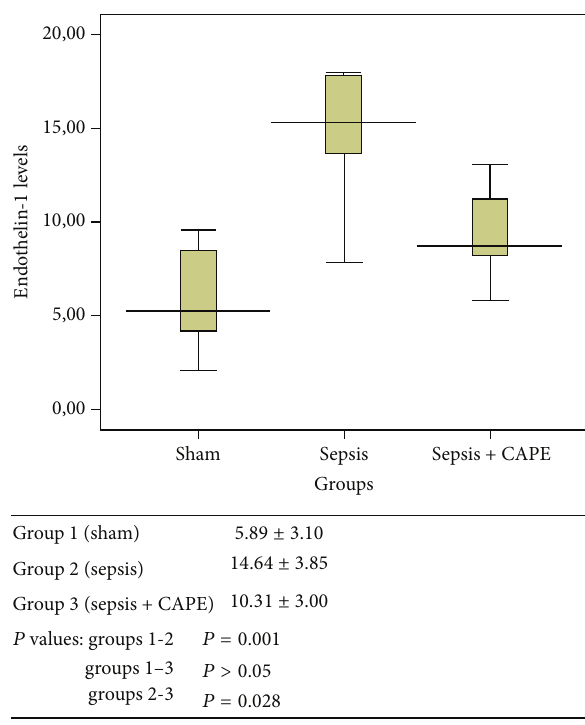
Figure 2: Serum TNF-alpha level (pg/mL) was described as mean value ± SD for all